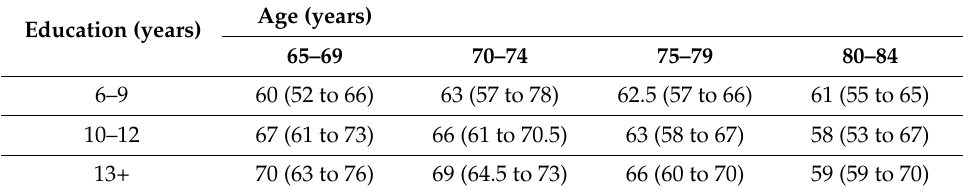
Table 4. Total Quick Mild Cognitive Impairment (Q mci -J) screen median scores (IQR) by age and education for presumed normative data based on with standardized Mini-Mental State Examination (sMMSE-J) scores ≥ 27 (n =